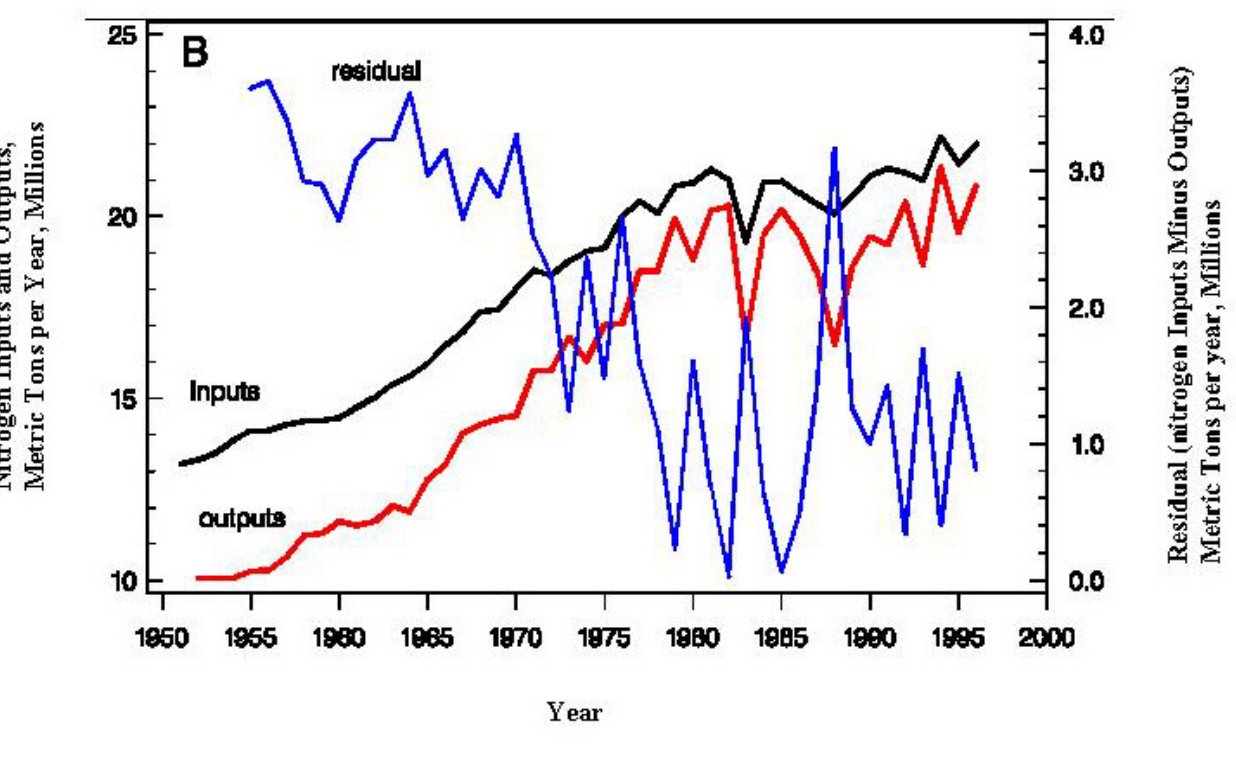
FIGURE 2 . Annual N inputs and outputs for the Mississippi-Atchafalaya River Basic from all major sources. From Goolsby et